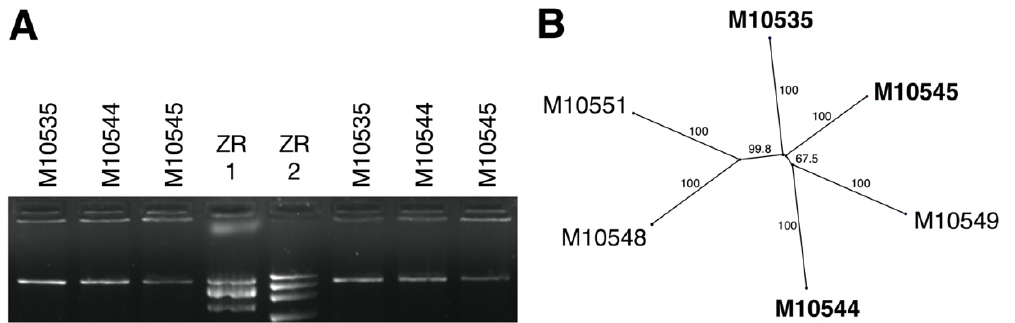
Figure 2. Characterization of dsRNA extracted from Cryphonectria naterciae . ( A ) Agarose gel electrophoresis of dsRNA used for RNA-seq before (left) and after (right) DNase and S1 nuclease treatment. ZR1: 10, 5, 3 kb; ZR2: 20, 7, 4, 2.5 kb, Thermo Scientific ZipRuler Express DNA Ladder Set (SM1373). ( B ) Unrooted neighbor joining tree of a 958 nt alignment including concatenated sequences of ORF1 and ORF2. Bold labels highlight strains associated with C. naterciae from Quercus suber ; others are from Castanea sativa . Numbers represent bootstrapping rate of 1000 replicates.